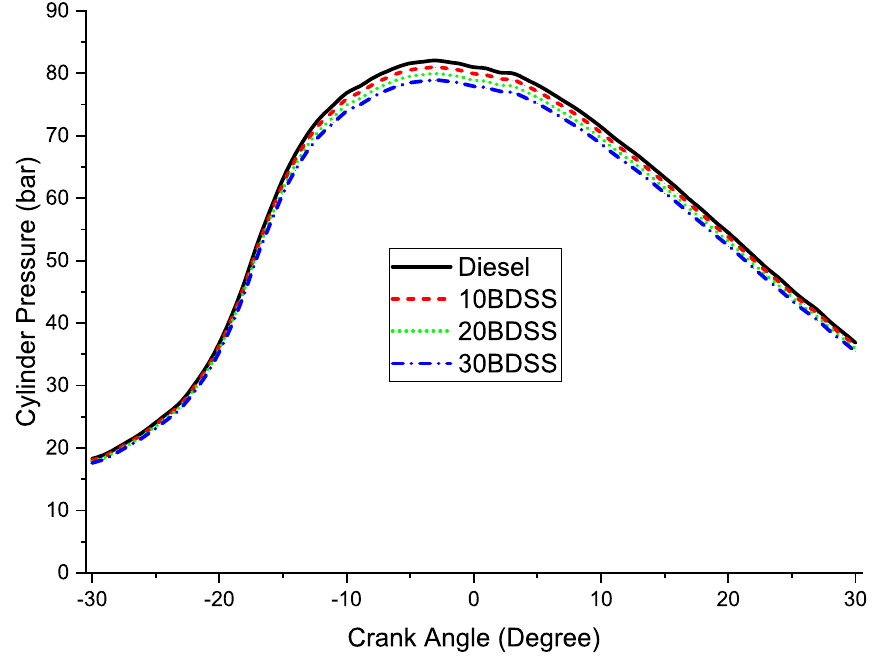
Figure 3. Cylinder Pressure differences on